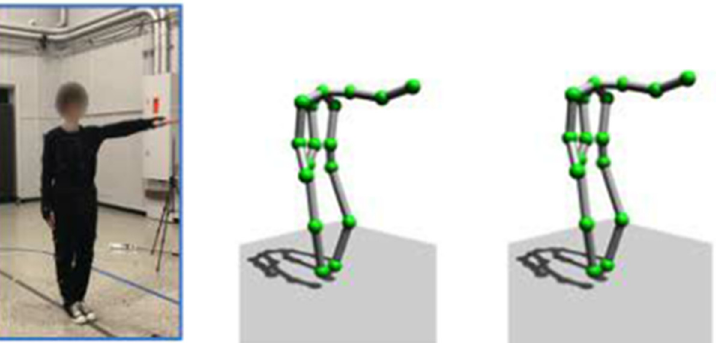
Figure 9. The three-dimensional human skeleton is generated by 5 GHz Wi-Fi CSI [51]. The images from left to right are the video frames, ground truth, and CSI predicted skeleton.